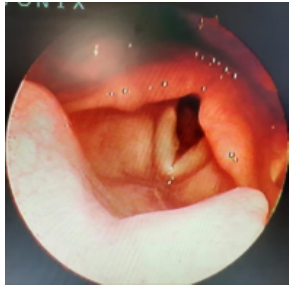
Figure 14. B/L early vocal polyp over anterior 1/3rd of vocal cords